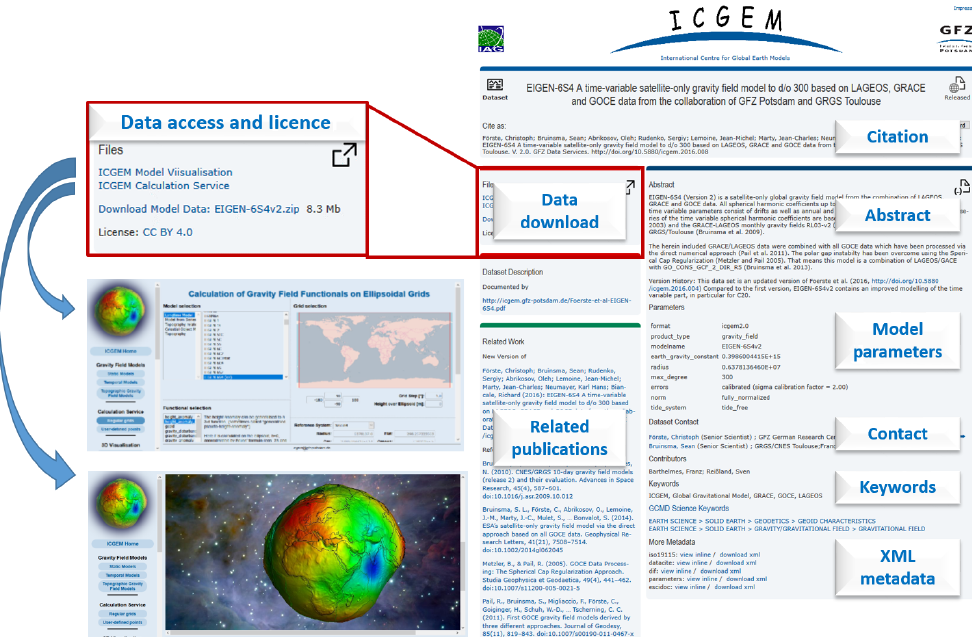
Figure 18. Example and features of an ICGEM DOI landing page (EIGEN-6S4, http://doi.org/10.5880/icgem.2016.008). The DOI landing page to the right is the visualization of the metadata for data discovery that is collected for the DOI assignment. In addition to the links to the data, it includes the citation information, a data description (abstract), a table of model parameters, contact information, keywords, and links to related publications. The metadata are also provided in machine-readable XML format. The key elements of the DOI metadata are also included in the header of the data files (model coefficients). The left part of the figure is a close-up of the data download section. GFZ Data Services store a copy of the model data and provide direct links to the ICGEM visualization and calculation services with the preselection of the actual model.